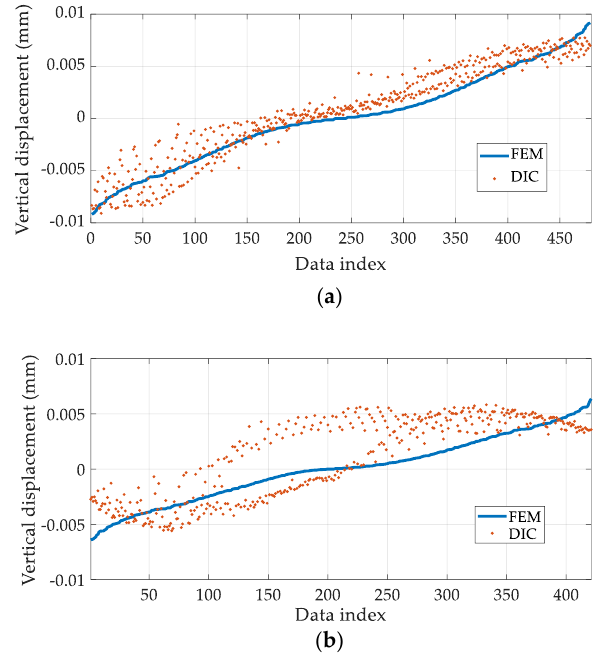
Figure 7. A pointwise comparison between the FEM results, scaled by the estimated stress and the DIC results, subtracted by the rigid body motion: ( a ) Test 1; ( b ) Test 5.